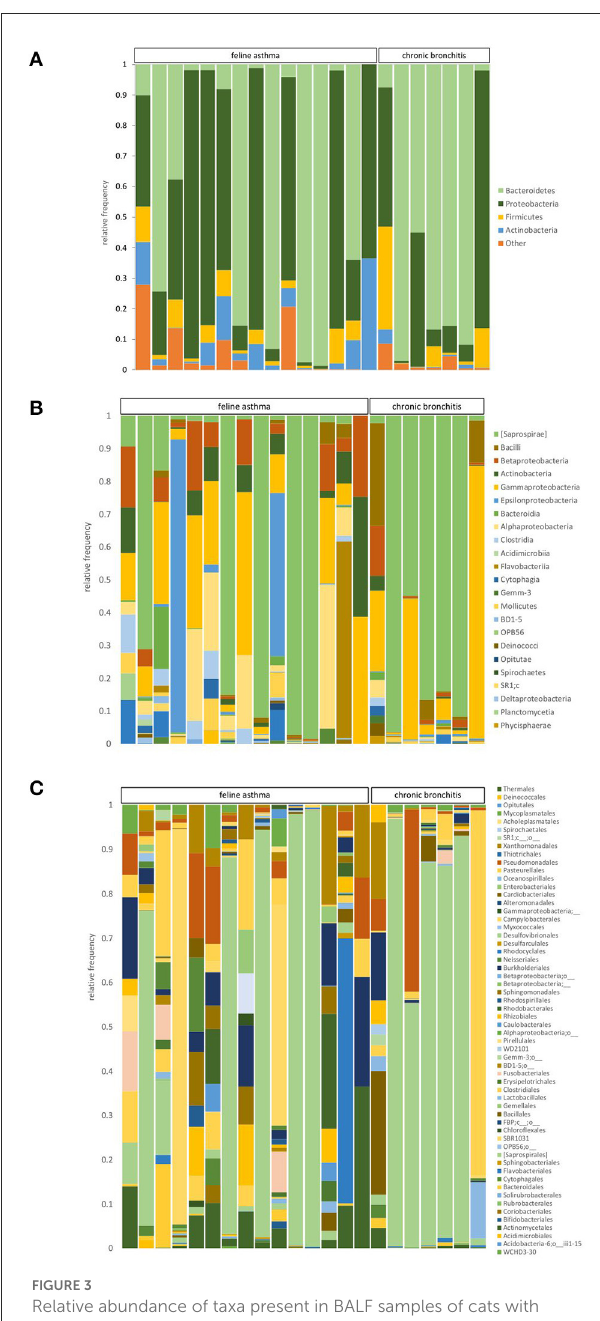
FIGURE3 Relative abundance of taxa present in BALF samples of cats with feline asthma and chronic bronchitis on a phylum (A) , class (B) , and order (C)